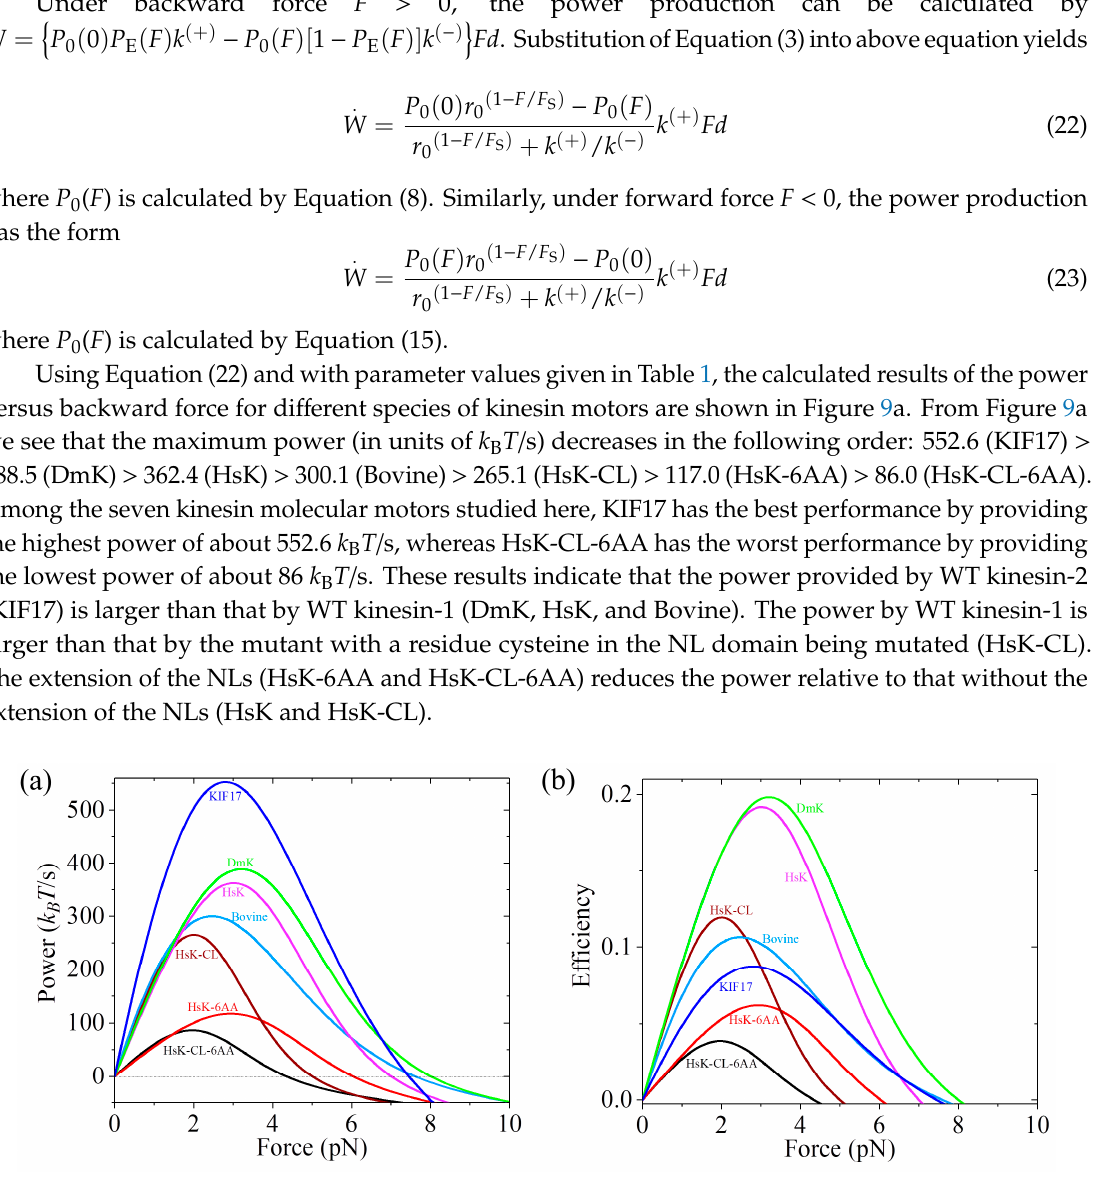
Figure 9. Analytical results of power production and efficiency of different kinesin motors versus backward force. ( a ) Force dependence of power production. ( b ) Force dependence of efficiency.